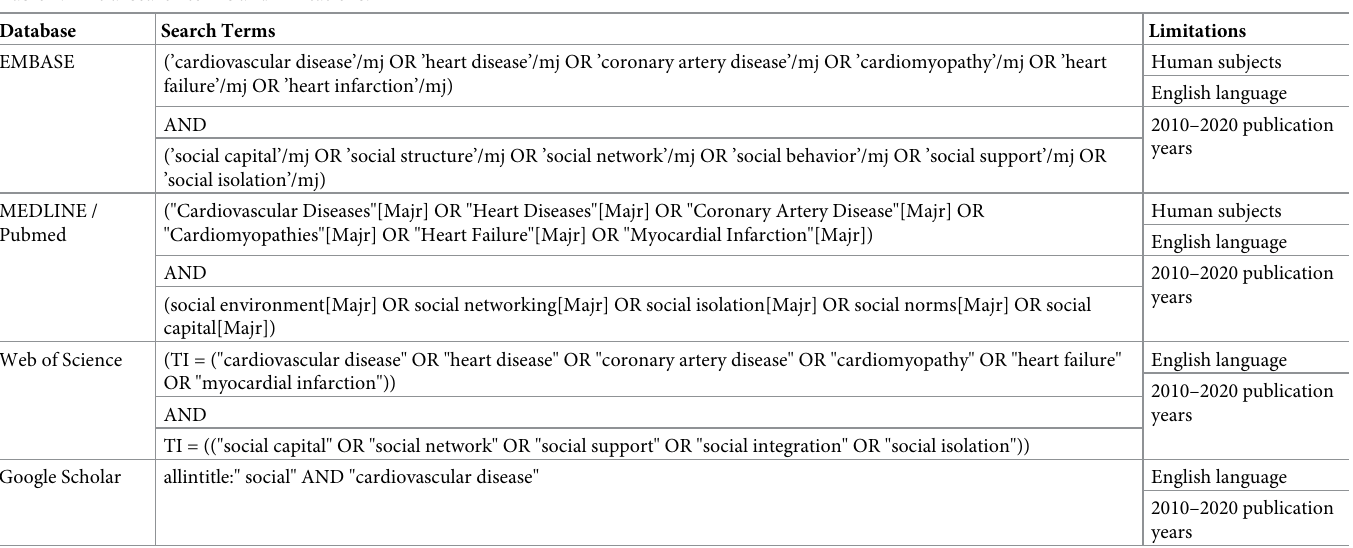
Table 2. Initial search terms and